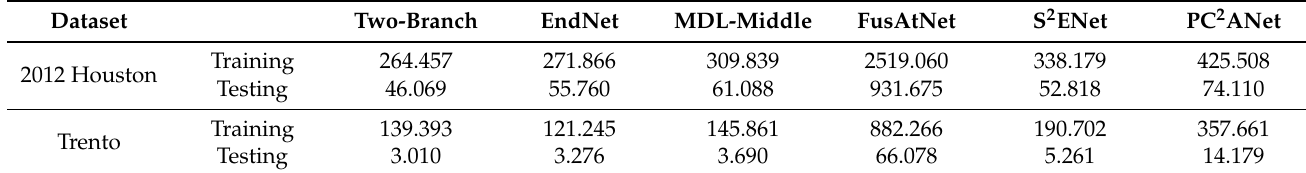
Table 7. Training and testing time (seconds) cost compared to advanced deep learning